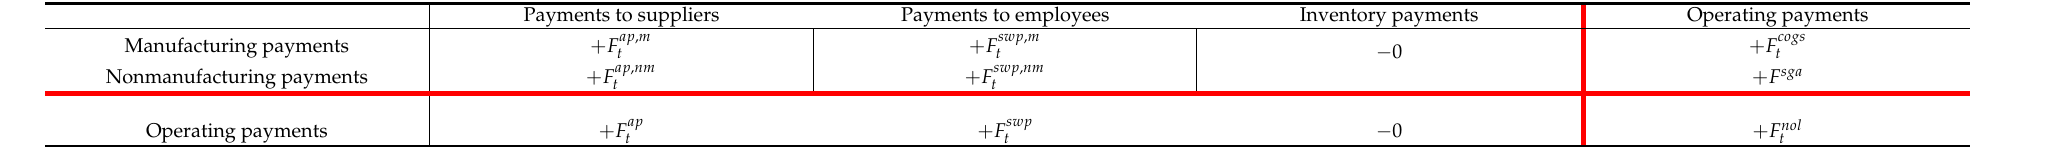
Table 3. Breakdown of operating